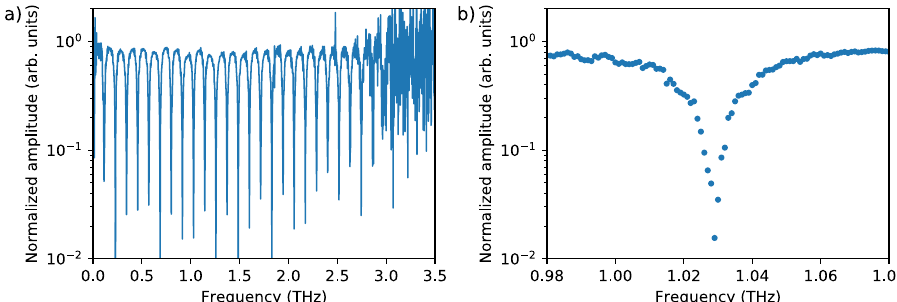
Fig. 6 Absolute value of the transfer function of a HRFZ-Si wafer, recorded in re fl ection geometry with a focused THz beam. The acquisition of 1000 averages leads to a total measurement time of 15 s. The THz path was purged with nitrogen gas to avoid water vapor absorption. The full THz spectrum ( a ) and a magni fi cation of a single Fabry – Pérot dip around 1.03 THz ( b ) are